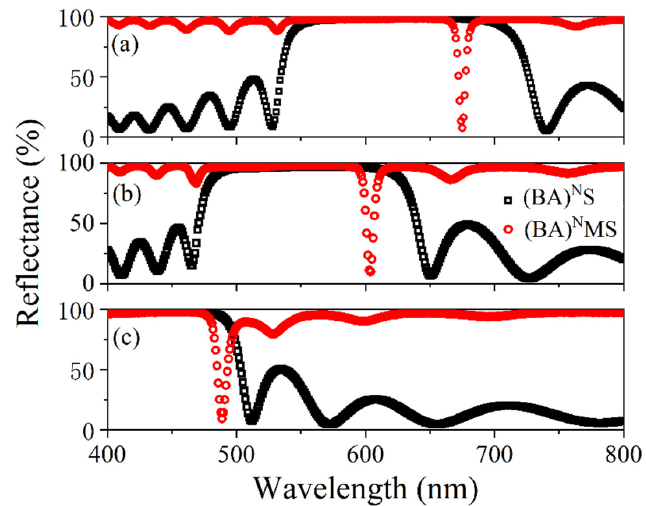
Figure 9. Measured reflection spectra of (BA) N MS (red circles) and (BA) N S (black circles). ( a ) (BA) 7 MS. ( b ) (BA) 8 MS. ( c ) (BA) 10 MS.